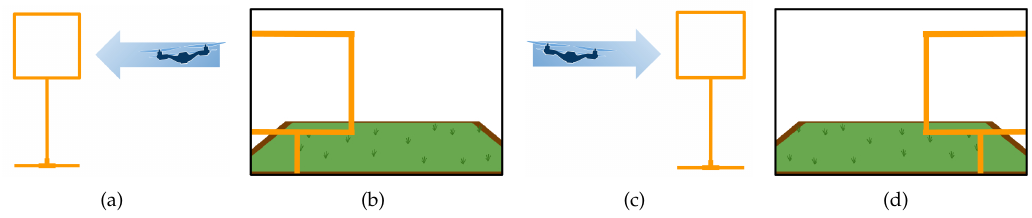
Figure 5. Schematic drone’s lateral motion: ( a ) outside view of the corresponding side motion when the gate appears to the left of the image ( b ); ( c ) corresponding side motion when the gate appears to the right of the image ( d ). The flight command φ will take values in the range of [ − 1,1 ] ; values for ( θ , ψ , h ) will be set to